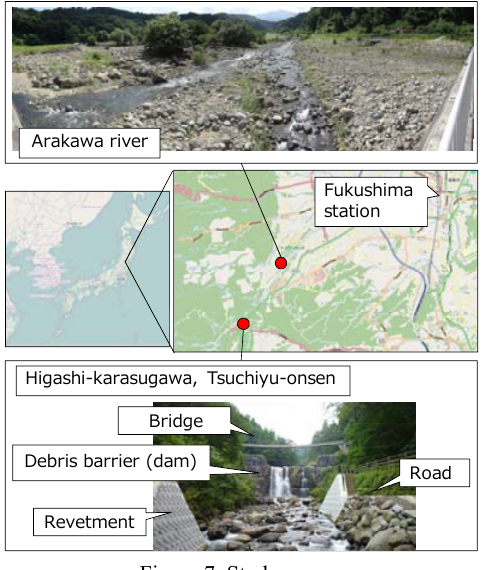
Figure 7. Study area